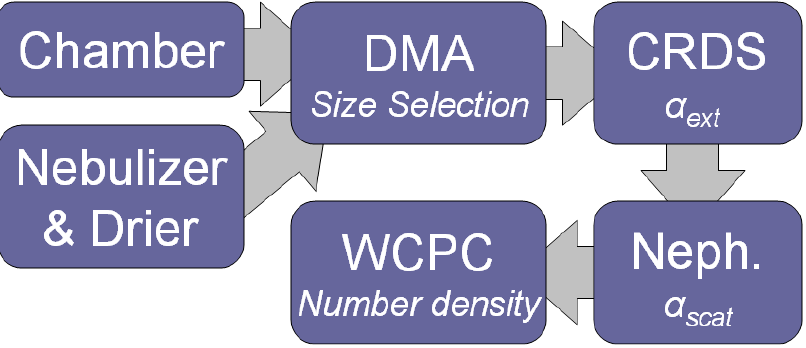
Figure 1. Schematics of the experimental set-up.